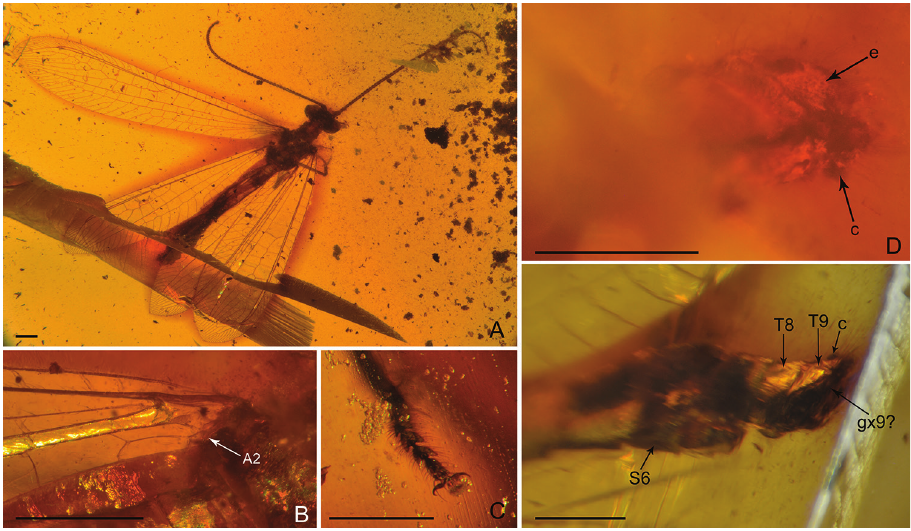
Figure 2. Parababinskaia makarkini sp. n., paratype female. A Habitus photograph, dorsal view B Pho- tograph of left hind wing base, dorsal view C Photograph of tarsus D Photograph of female genitalia, dorsal view E . Photograph of female genitalia, ventral view. Abbreviations: T: tergum; S: sternum; c: callus cercus; e: ectoproct; gx: gonocoxite. Scale bars: 1.0